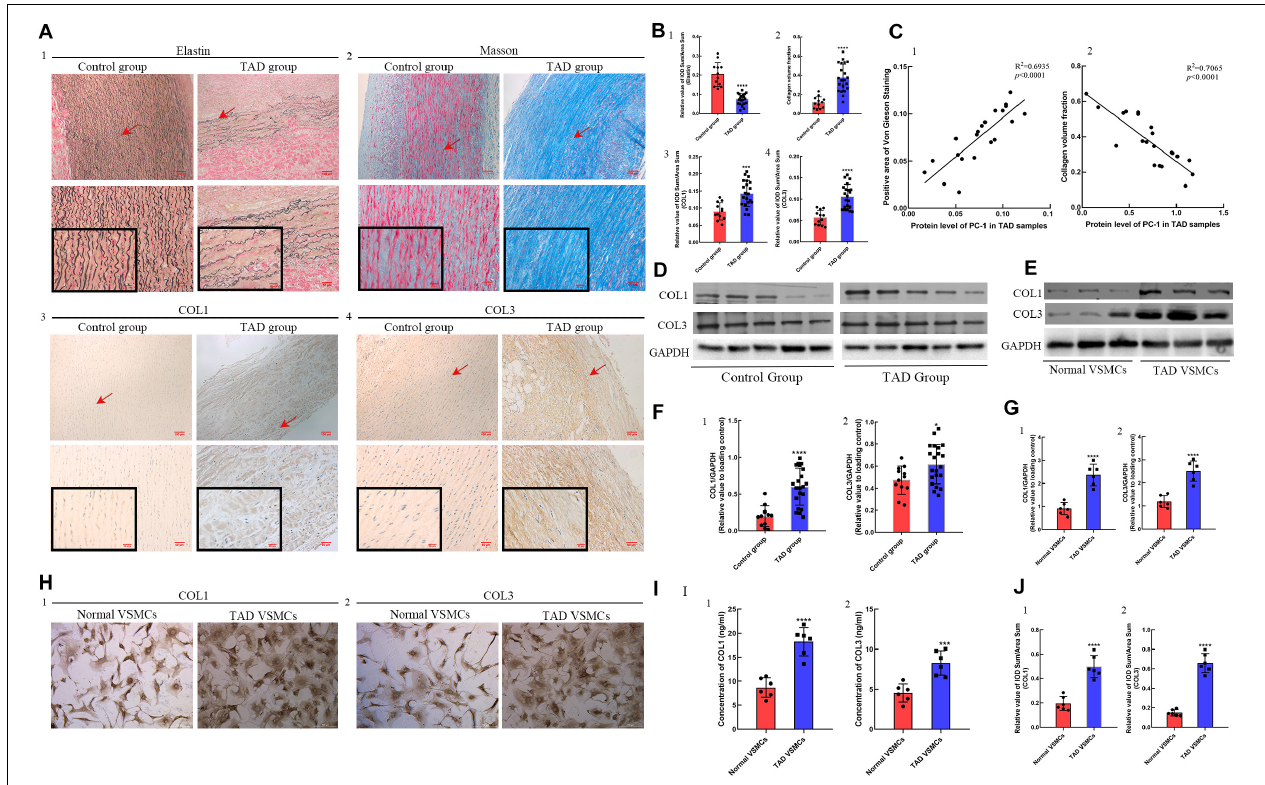
FIGURE 2 | ECM staining in control ( n = 12) and TAD group ( n = 21) and protein expression between normal and TAD VSMCs. Decreased positive area of (A1,B1) von Gienson elastin staining in TAD group ( p < 0.0001). (A2,B2) Increased collagen volume fraction ( p < 0.0001), positive area of (A3,B3) collagen I ( p = 0.0002) and (A4,B4) collagen III ( p < 0.0001) in TAD group. The PC-1 expression was (C1) positively correlated with the positive area of von Gienson elastin staining ( R 2 = 0.6935, p < 0.0001) and (C2) negatively correlated with the collagen volume fraction ( R 2 = 0.7065, p < 0.0001) in TAD samples. Increased synthesis of (D,F1) collagen I ( p < 0.0001) and (D,F2) collagen III ( p = 0.0199) in TAD group. The synthesis of (E,F1) collagen I ( p = 0.0007, p < 0.0001) and (E,F2) collagen III ( p = 0.0019, p < 0.0001) was increased in TAD VSMCs. (G1,2) These pictures showed the protein expression of COL1 and COL3 between normal and